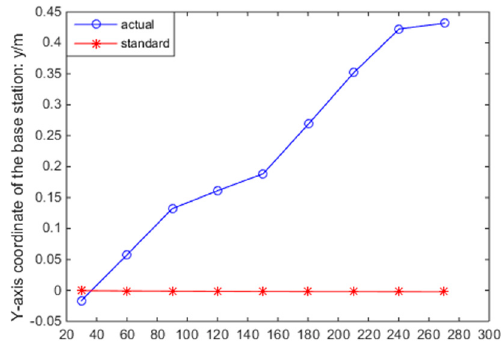
Electronics 2020 , 8 , x FOR PEER REVIEW Figure 13. Error variation chart as base station location changes (one side). Figure 13. Error variation chart as base station location changes (one side).